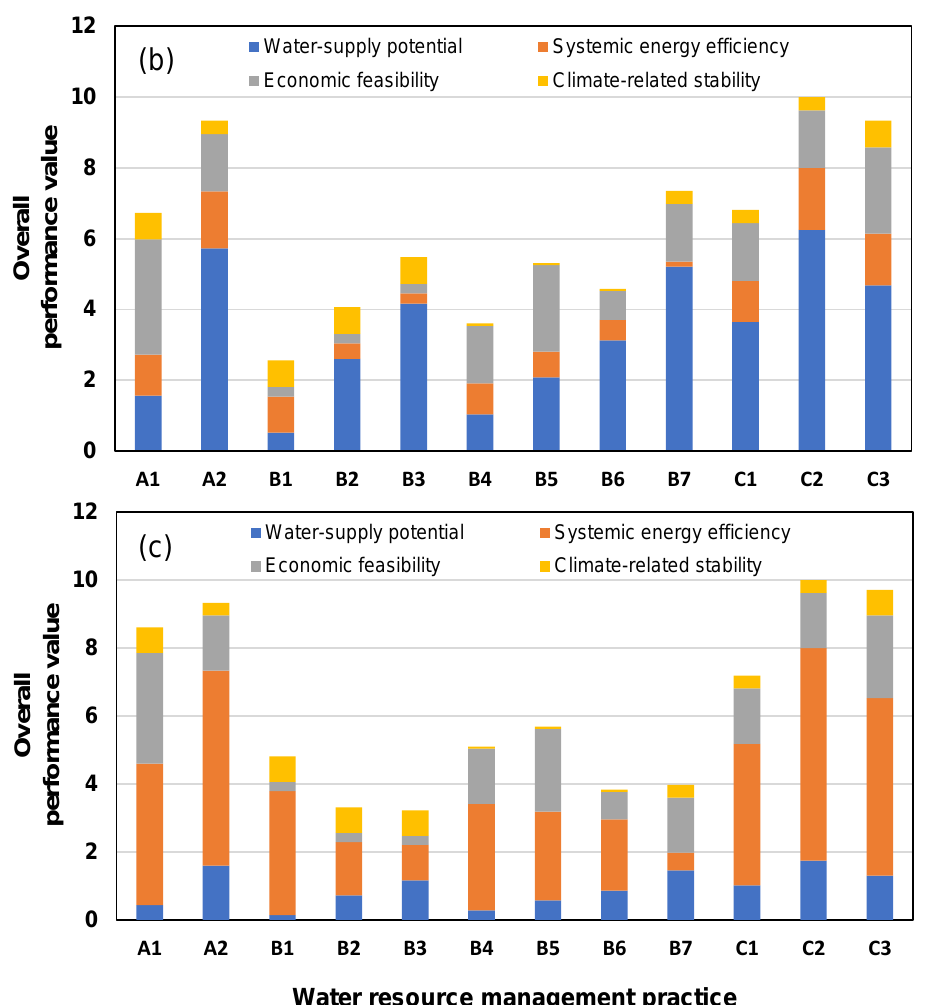
Figure 4. Results of sensitivity analysis: ( a ) equally weighted; ( b ) water-supply potential ranked first; ( c ) systemic energy efficiency ranked first. Results in ( a ) can also be easily transferred to original ranking score of its corresponding criteria by multiplying a factor of 4.